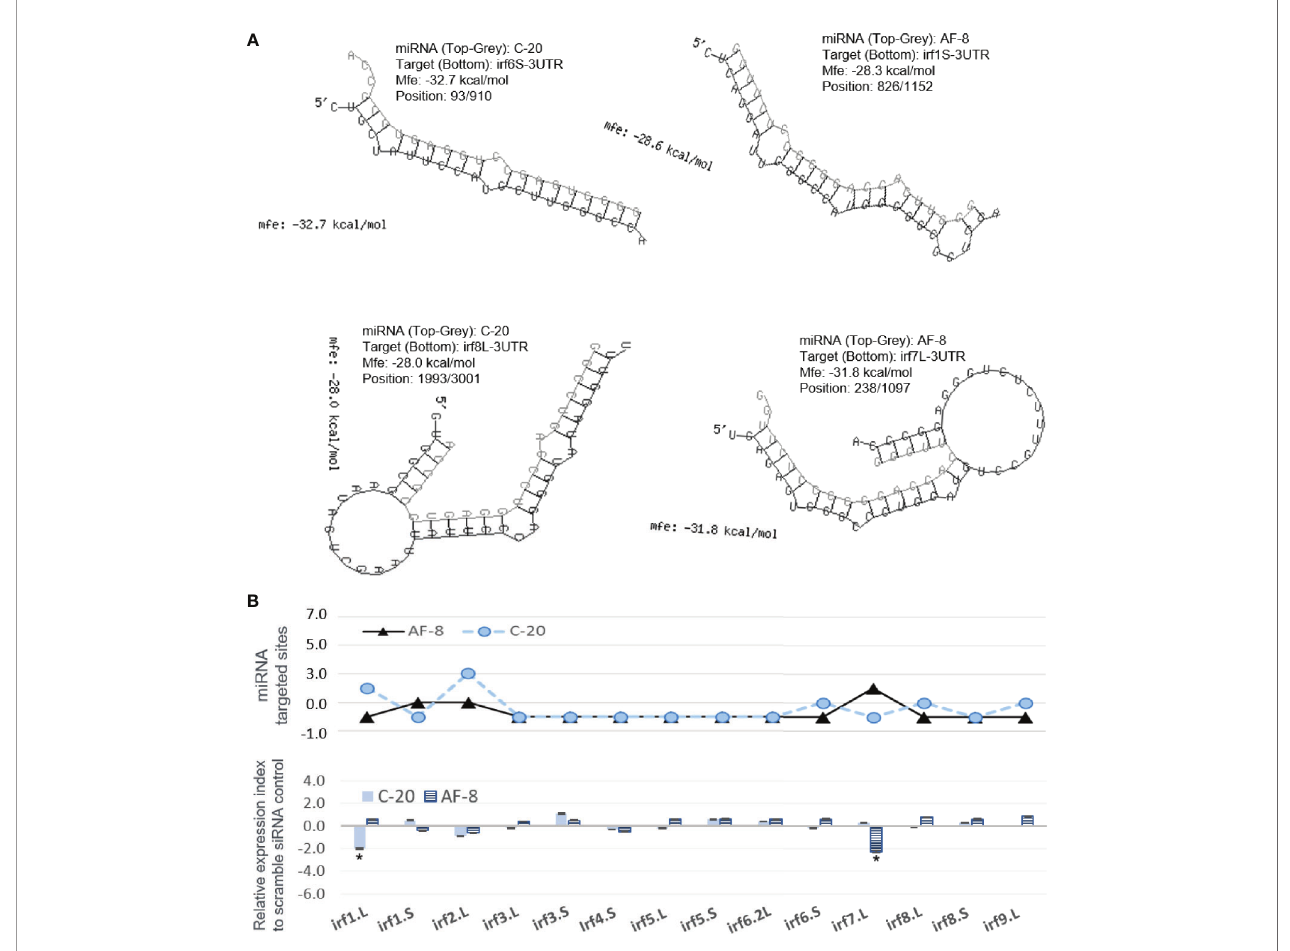
FIGURE 11 | Examples of miRNA that are predictably targeted on 3 ’ -UTR regions of X. laevis mRNA encoding several IRF genes. (A) Hybridization of individual miRNA with its mRNA targets was performed using a program of RNAhybrid with its accompanying programs RNAcalibrate and RNAeffective as described. The hybridization structures and minimum free energy (Mfe) are given, the thresholds of Mfe was set as -28.0 kcal/mol to re fl ect typical Mfe of miRNA (like let7) hybridization to mRNA targets. MiRNA C-20 and AF-8, the twentieth and eighth miRNA in the C and AF group, respectively, as illustrated in Figure 2 and Supplement Excel sheet for sequence detail. (B) Schematic shows validation using synthetic siRNA with identical sequences to representative miRNAs. Synthesis of siRNAs and transfection of X. laevis A6 cells were performed as described, and gene speci fi c RT-PCR was used to quantify the expression of target genes. Top panel : Line chart representing numbers of predicted sites targeted by miRNA AF-8 (black triangles) and C-20 (blue cicles) on the 3 ’ -UTR of each template target. Bottom panel : Bar chart of relative gene expression obtained with C-20 (blue histogram) and AF-8 (hachured histogram) miRNAs. The GenBank Accession numbers of the tested transcripts are listed in Table 2 . *p < 0.05, n = 5 relative to the sample transfected using a scramble